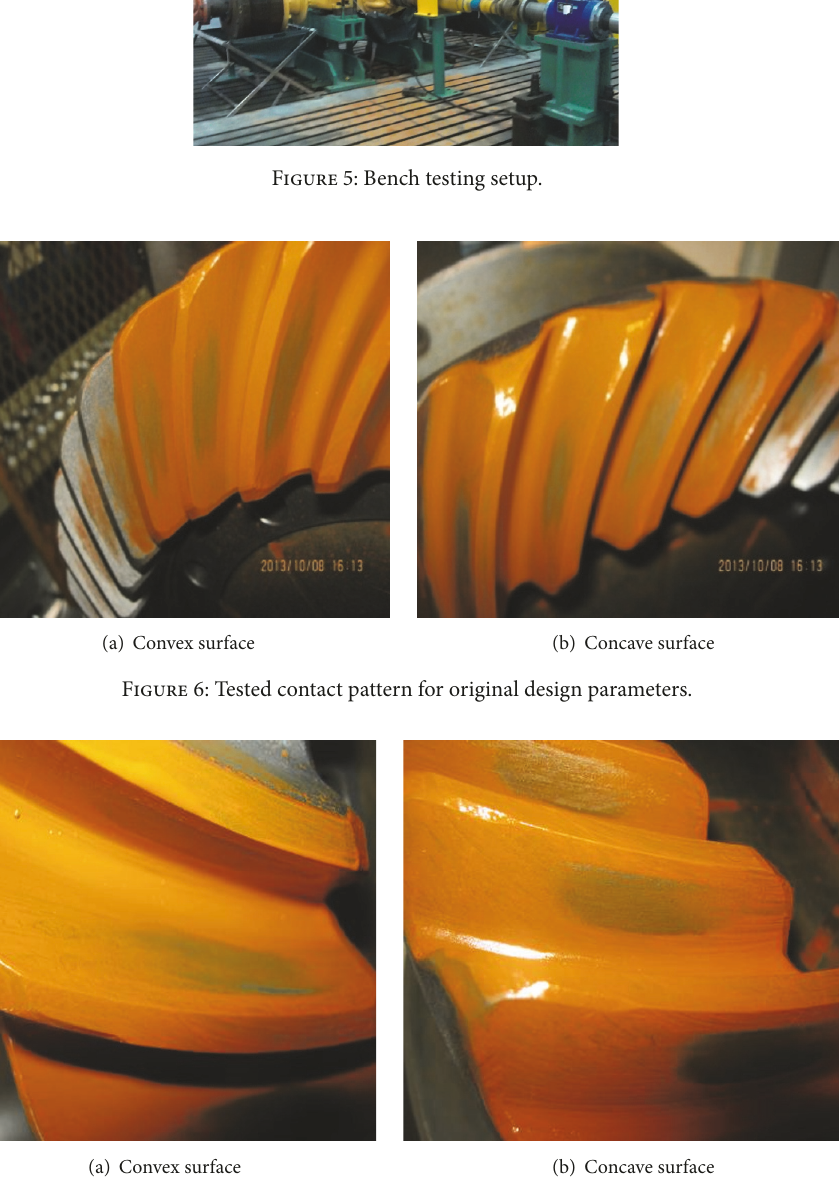
Figure 7: Tested contact pattern for optimized design